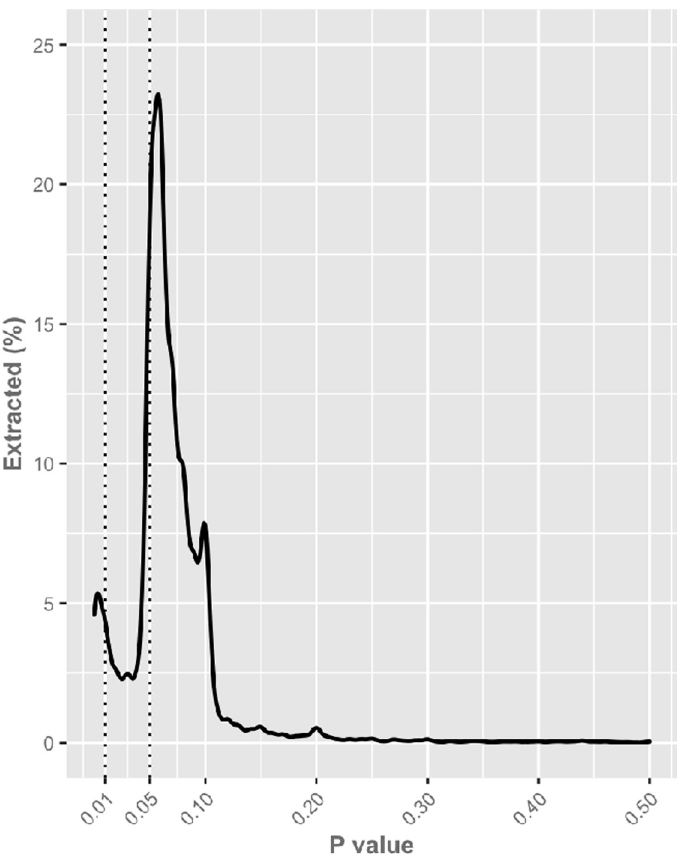
Fig 4. Density plot of the 11,926 manually extracted P values. The data can be found here: https://github.com/ wmotte/almost_significant/tree/main/Fig_and_Data.